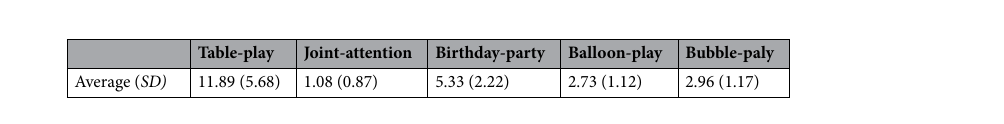
Table 2. The time duration for 5 activities (Unit: minutes).